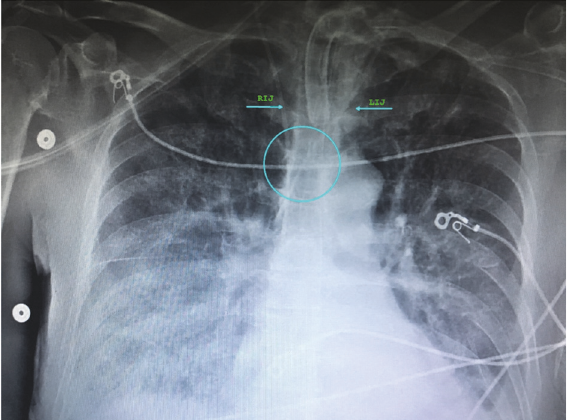
Figure 2: Chest X-ray showing tracheostomy tube, superficial EKG electrodes, and two central venous catheters via left and right internal jugular access in proximity almost parallel position in SVC with 20-degree angle at